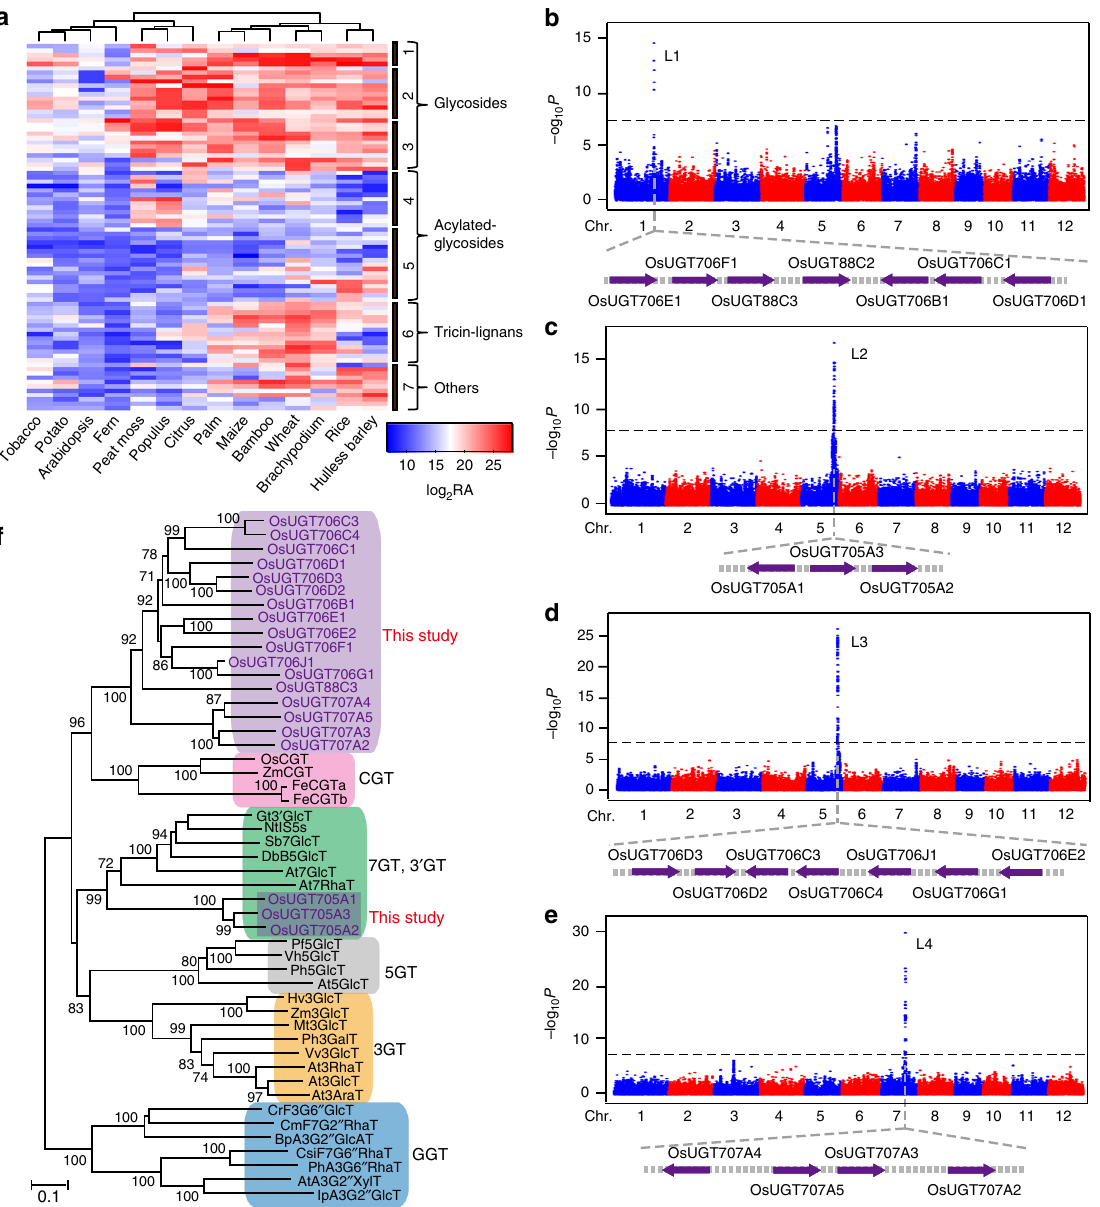
Fig. 1 Identi fi cation and phylogenetic analysis of fl avonoid UGTs in rice. a LC-MS pro fi ling of fl avonoids in 14 species across the plant kingdom. Heat map visualization of relative differences of fl avonoids by the average of all values in two biological replicates. Scatterplots of association results for 4 fl avonoid traits across the 12 rice chromosomes. The strength of association is indicated as the negative logarithm of the P value for the linear mixed model. All metabolite-SNP associations with P values below 6.6 × 10 – 8 (horizontal dashed lines in all Manhattan plots) are plotted against genome location in intervals of 1 Mb. Traits are as follows: apigenin 7- O -glucoside in leaf ( b ), tricin O -hexoside- O -hexoside in seed ( c ), chrysoeriol O -feruloylhexoside- O -hexoside in leaf ( d ), apigenin 5- O -glucoside in leaf ( e ). The Manhattan plots from six individual replicate (two replicates in leaf and four replicates in seed) for each locus are provided in Supplementary Fig. 3. Candidate glycosyltransferases within each locus are in purple. f An unrooted phylogenetic tree was constructed as described in Methods. OsUGT88C2, which shows 89% identities to OsUGT88C3, was not shown in this tree as its short protein length. Bootstrap values > 70% (based on 1000 replications) are indicated at each node (bar: 0.1 amino acid substitutions per site). RA, relative peak area